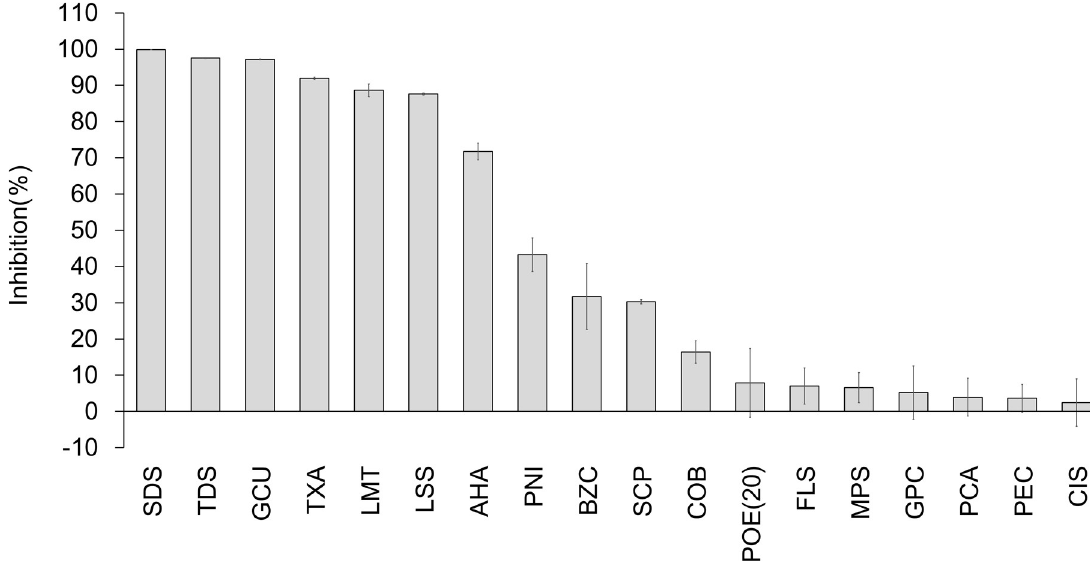
Fig 3. Screening of toothpaste and mouthwash ingredients exhibited inhibitory effects on the serine protease activity of TMPRSS2. Eighteen toothpaste and mouthwash ingredients at 1% (w/w) exhibited inhibitory effects on the TMPRSS2 serine protease activity. TMPRSS2 cleaved Boc-Gln-Ala-Arg-MCA as the substrate and produced the potent fluorophore, AMC (7-amino-4-methylcoumarin). Values were normalized against the intensity of the absence of test ingredients. Data are expressed as the mean ± SD (n = 3).